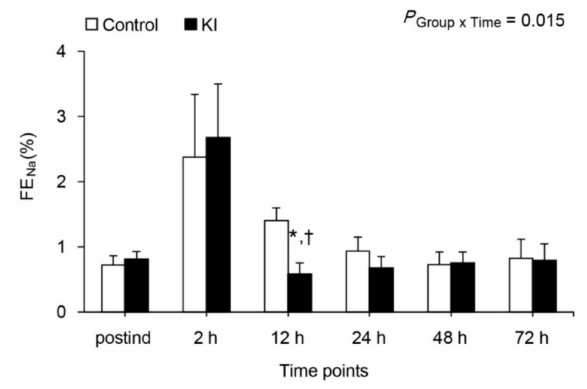
Figure 3. FE Na . * p < 0.05 compared to control group, † p < 0.05 compared to postind. FE Na , fractional excretion of sodium; postind, 10 min after anesthesia induction; 2, 12, 24, 48, and 72 h, 2, 12, 24, 48, and 72 h after renal artery declamping.